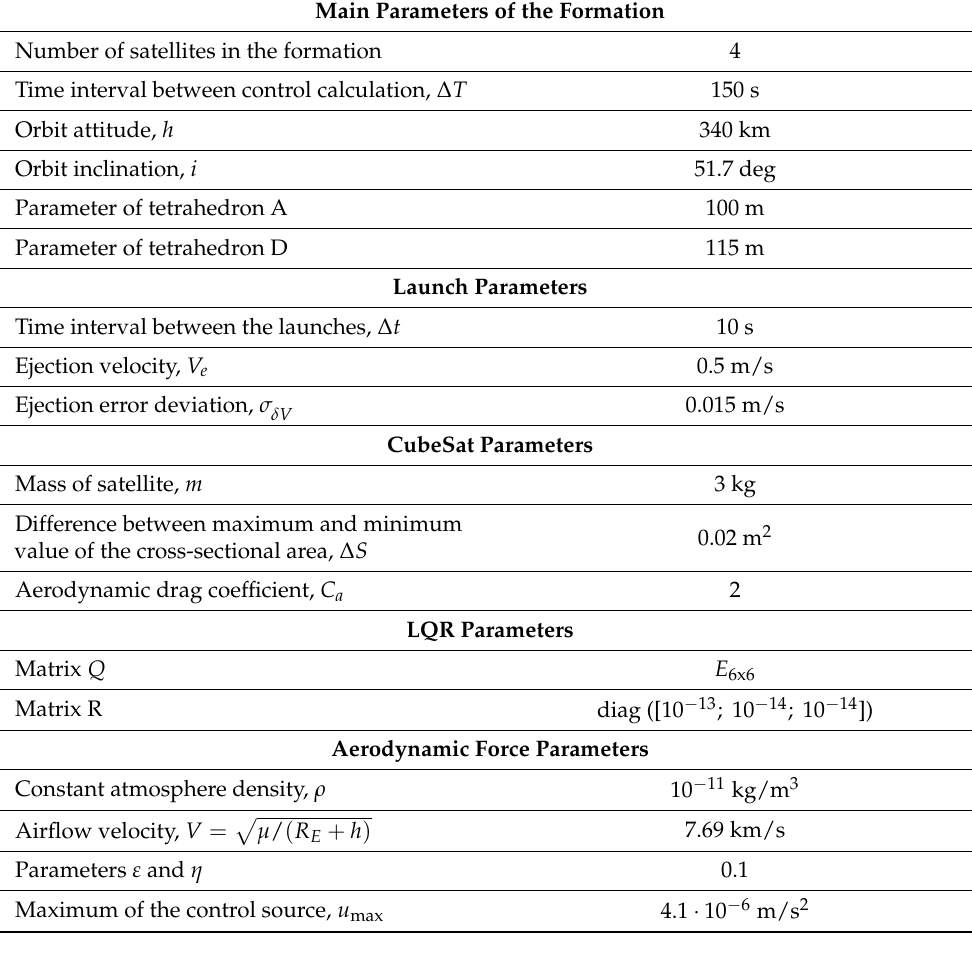
Table 1. Parameters and initial conditions of the numerical simulation.